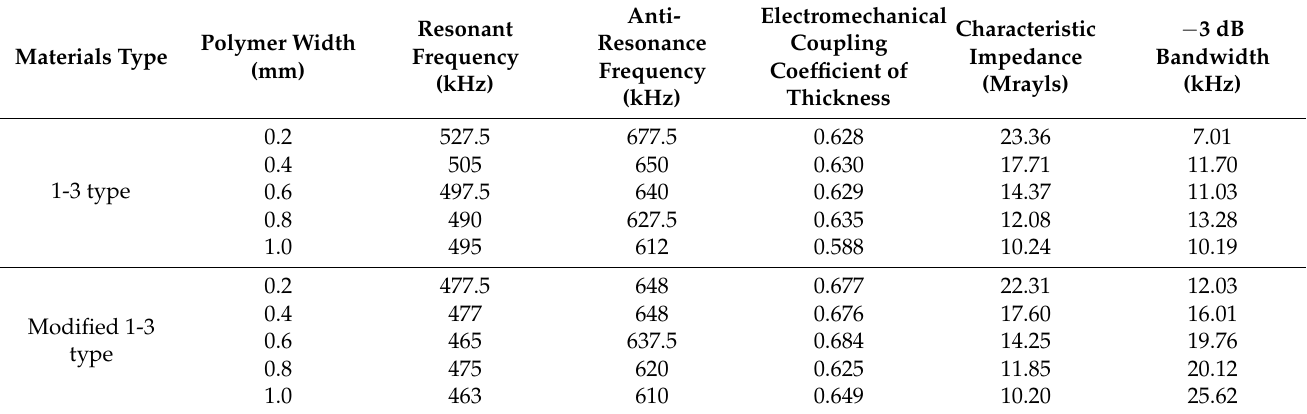
Table 4. Performance test data of 1-3 type and modified 1-3 type piezoelectric composites.